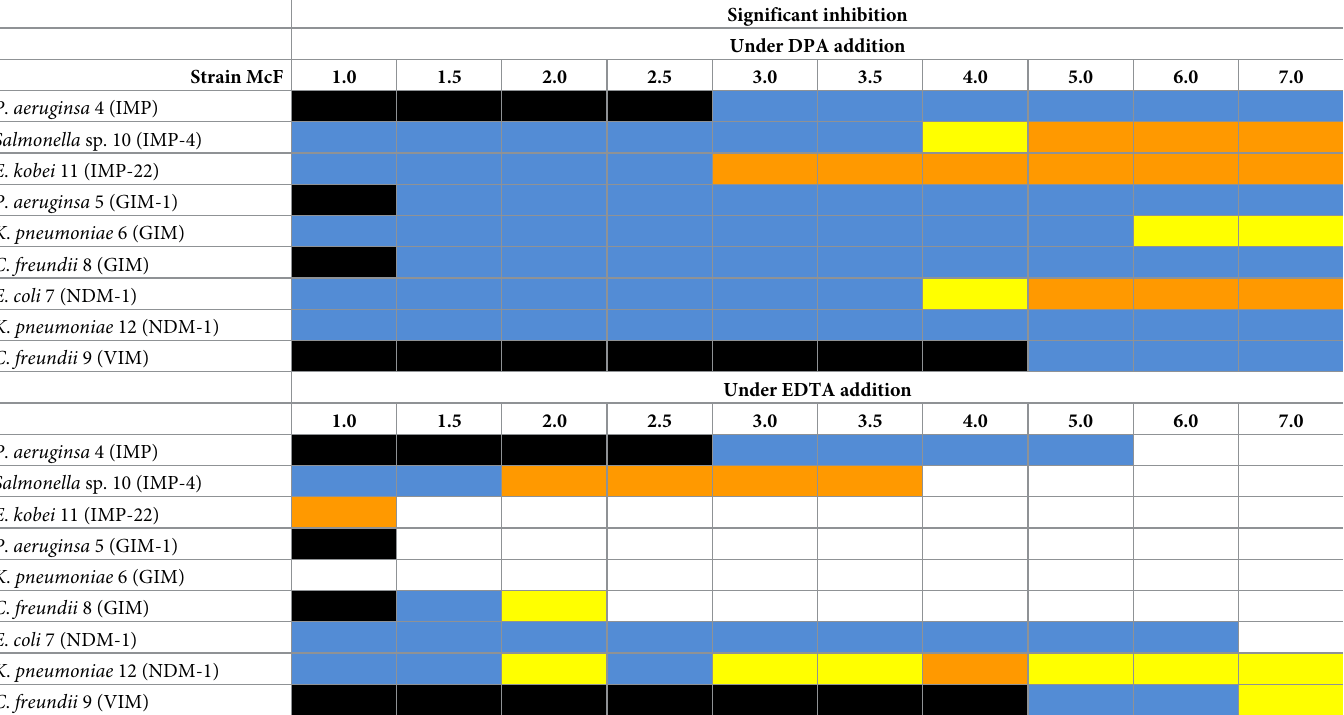
Table 4. Decrease in the level of hydrolytic activity of the metallo- β -lactamases producing strains under DPA and EDTA addition depending on the bacterial sus- pension